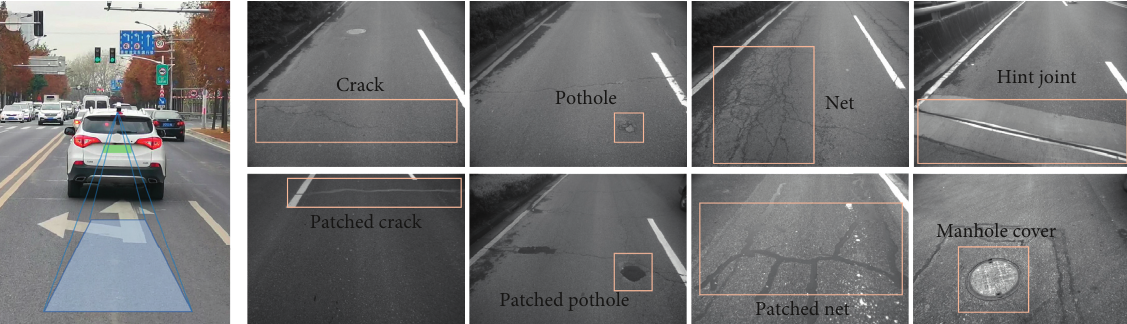
Figure 2: The targeted pavement